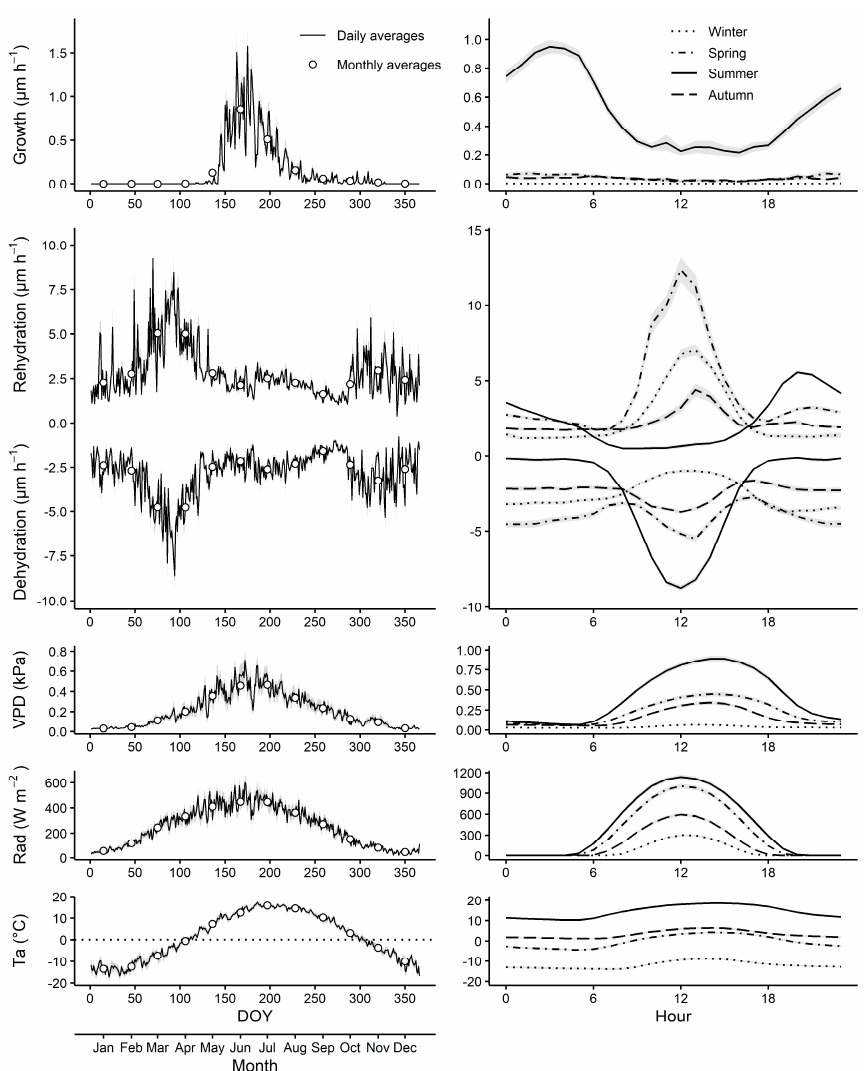
Figure 2. ( left ) Annual pattern of daily and monthly stem radius variation and ( right ) seasonal diel pattern associated with growth and tree water status variations (dehydration and rehydration) for all monitored trees (averaged) over the 11-year period (2009–2020) along with pattern of vapour pressure deficit (VPD), solar radiation (Rad), and air temperature (Ta) over the same period. Shaded area shows 95% con fi dence interval for the mean.